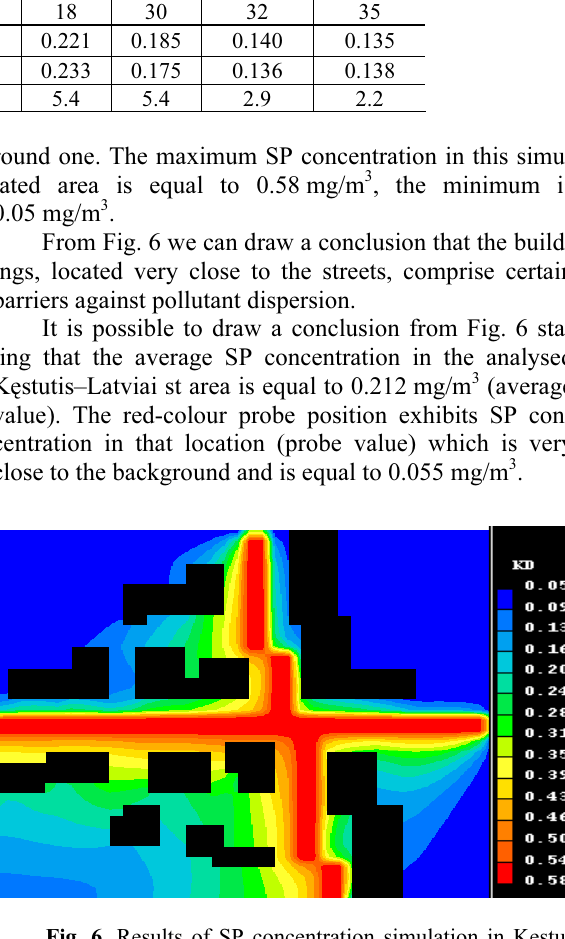
Fig. 6. Results of SP concentration simulation in